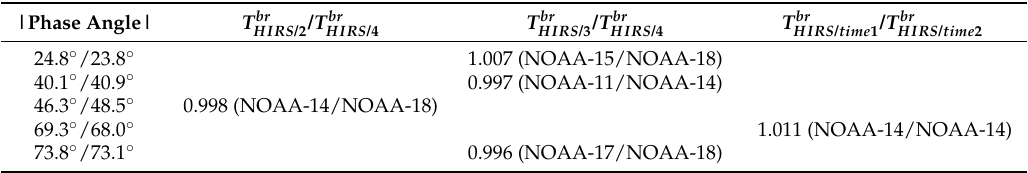
Table 3. Ratio of the average brightness temperature T br of the Moon as measured with channels 13-17 (no channel but 17 was used for the calculation of the pair 24.8 ◦ /23.8 ◦ ) of HIRS on different satellites. As the brightness temperatures were derived from less than six measurements, we did not calculate uncertainties based on their scatter. The value in bold face refers to the only pair, where both measurements were made with the same instrument on the same satellite, but at different times. It is also the only pair, where the measurements were made close to minimum and maximum distance between the Sun and the Moon, which explains the large